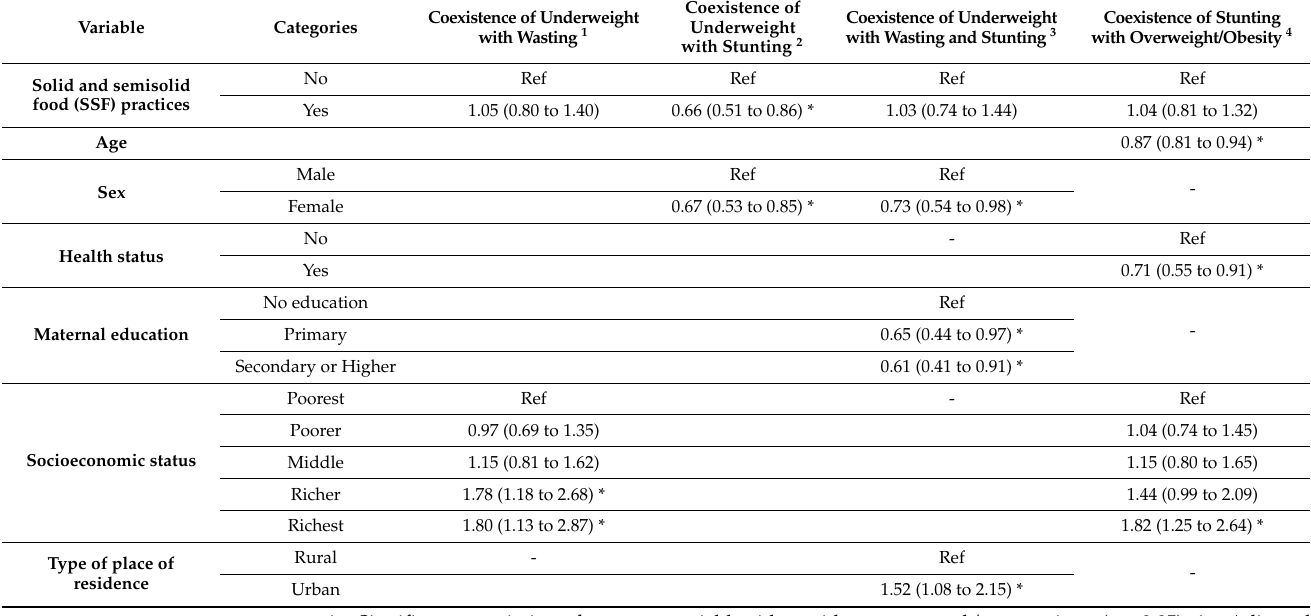
Table 4. Multinomial adjusted model for associations between use of solid, semi-solid, and soft foods and CFM.